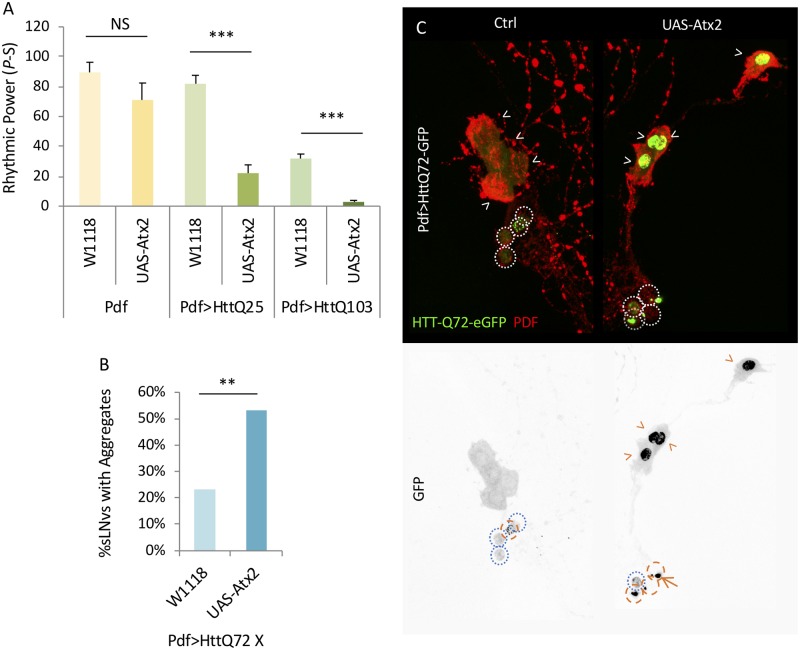
ATX2 overexpression enhances mhtt aggregation.A. Rhythmic power (P-S) is indicated for various genotypes including flies expressing ATX2 in PDF neurons (UAS-Atx2) or in the wild-type control background (W1118) together with HttQ25 or HttQ103 (Pdf>HttQ25 or Pdf>HttQ103 n = 22–64; *:p<0.05 **p<0.01, ***:p<0.005, error bars represent standard error) B. Percentage of sLNvs (labeled with PDF in red) at age day 7 containing HttQ72-eGFP aggregates (in greee) in a wild-type background (W1118) and overexpressing ATX2 (UAS-Atx2) is quantified (n = 15–25; *p<0.05, **p<0.01, ***:p<0.005). C. Representative images of sLNv and lLNv for corresponding genotypes in B are shown. White arrowheads indicate lLNvs. White dot circles label sLNvs in the merged figure. Orange dash circles label sLNvs with aggregates while blue dot circles label sLNvs without aggregates in the grey scale of the green channel. Example aggregates are pointed out by orange arrows.